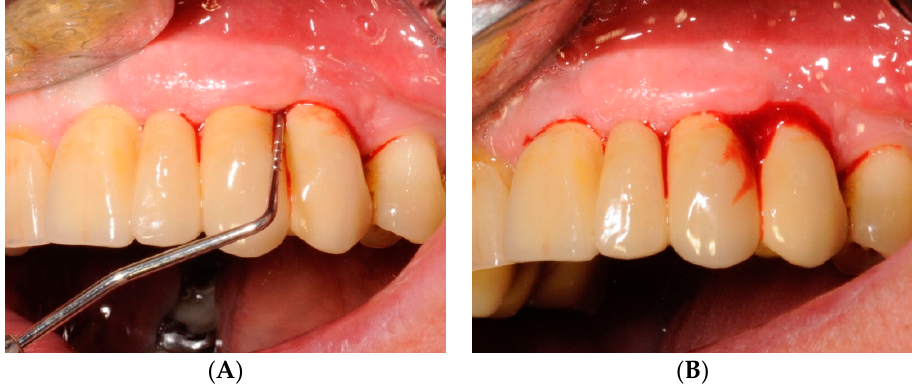
Figure 5. Soft tissues assessment at baseline. The implant affected by mucositis presented PPD ≥ 4 mm ( A ) and presence of BOP ( B ) and no radiographically detectable bone loss (Qualifying site).